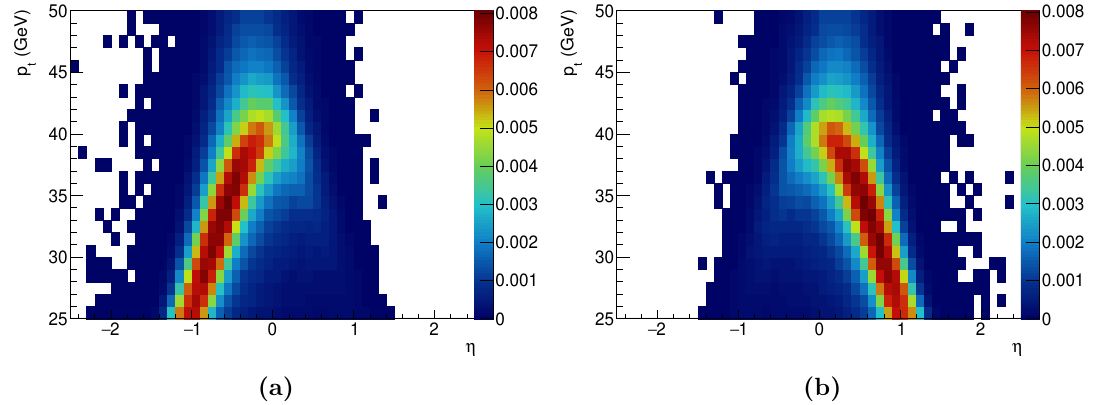
Figure 3 . p t vs. (cid:17) distributions for leptons from W + generated with rapidity (cid:0) 0 : 2 < y < 0 : 2. The normalised distributions are shown for W of positive (a) and negative (b) helicity.